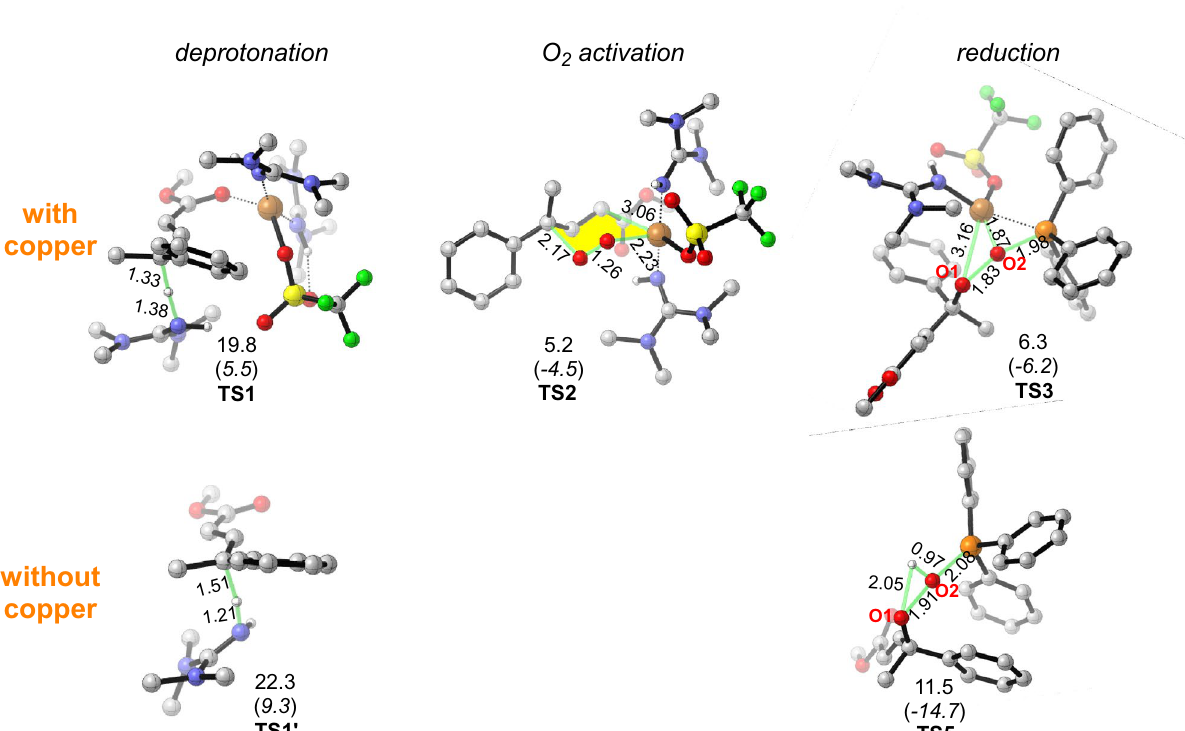
Figure 2. The deprotonation, O 2 activation and reduction transition states. Relative free energies (electronic energies) are in kcal/mol. The bond distances are given in Angstroms (Å). Note CYLview, 1.0b, https ://www.cylvi ew.org/downl